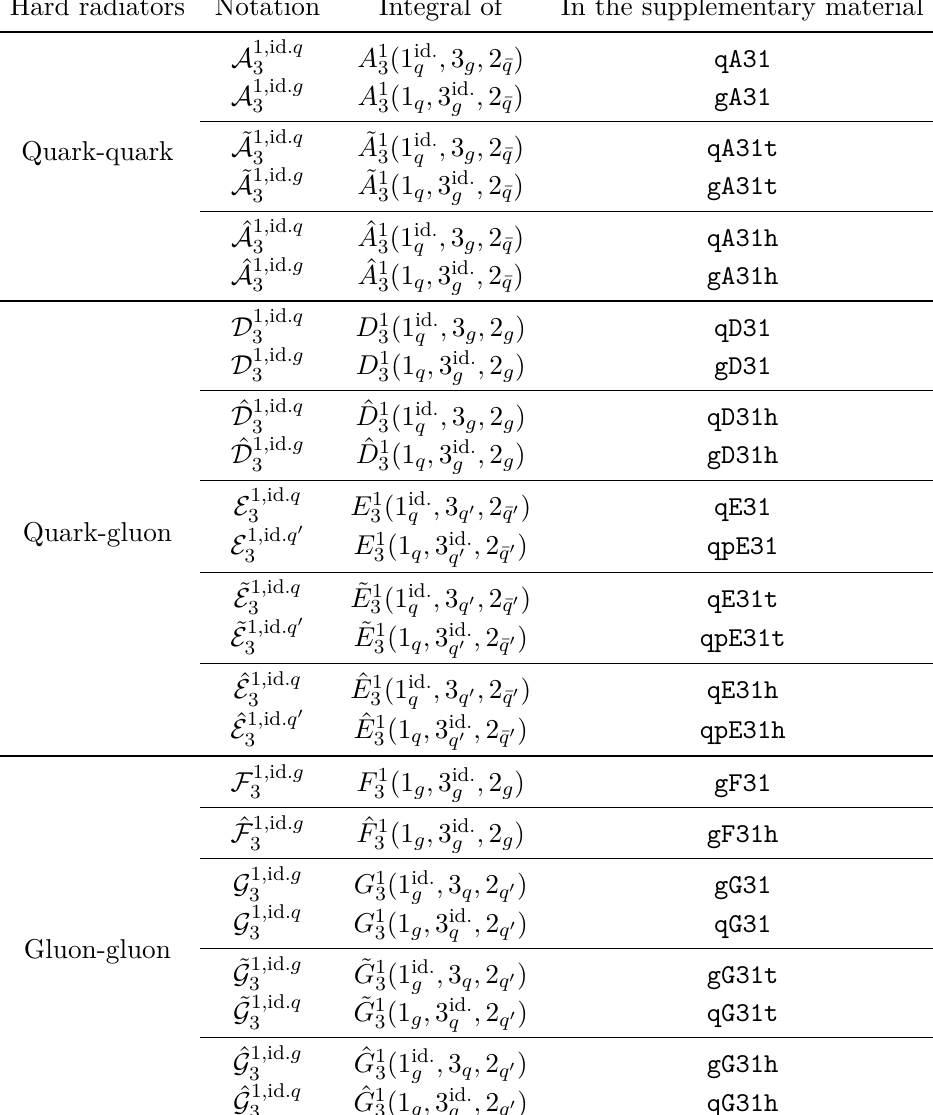
Table 2 . Integrated one-loop three-parton antenna functions X 1 , id .p